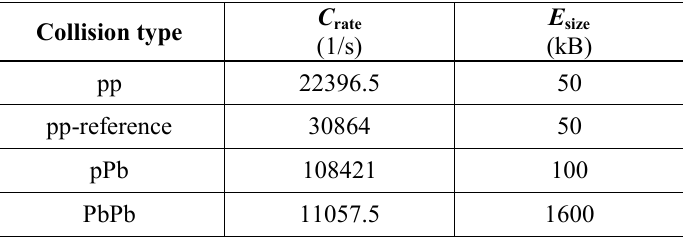
Table 2 lists the values of LHC conditions planned for Run 3. Table 2. LHC beam type and collision rates planned for Run